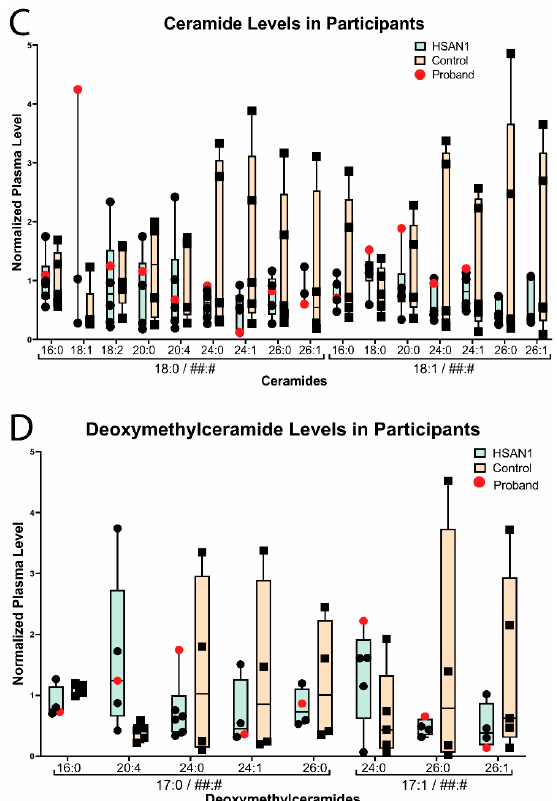
Figure 5. Sphingolipid bases, deoxyceramide, ceramide, and deoxymethylceramide plasma levels. Normalized plasma levels in participants with HSAN1 vs. control group measured by quantitative mass spectroscopy. Non-normalized values can be found in Supplementary Table S1. In all graphs, the proband’s value is marked in red. The nomenclature for the ceramide/deoxyceramide species, which are composed of a sphingolipid/deoxysphingolipid base plus a fatty acid, is as follows: for species (A:B/X:Y), A is the carbon length of the sphingolipid/deoxysphingolipid base, B is the number of unsaturated bonds in sphingolipid/deoxysphingolipid base A, X is the carbon length of the fatty acid, and Y is the number of unsaturated bonds in fatty acid X. The species are grouped by sphingolipid/deoxysphingolipid base (indicated by brackets, with the fatty acid placeholder denoted as “##:#”) and are labeled along the x -axis by their fatty acid chain. ( A ) Relative levels of deoxysphingolipid and sphingolipid bases: deoxysphingosine (deoxySO), deoxysphinganine (deoxySA), and four species of sphingolipid bases. ( B ) Relative deoxyceramide species levels, demonstrating elevated levels in the proband compared to other participants, including HSAN1- only-affected family members. This is particularly true for deoxysphingosine base (18:0) and acyl chains that were 18–20 carbons long. ( C ) Relative ceramide species levels, showing no correlation to HSAN1 status. ( D ) Relative deoxymethylceramide species levels, which also show no correlation to HSAN1